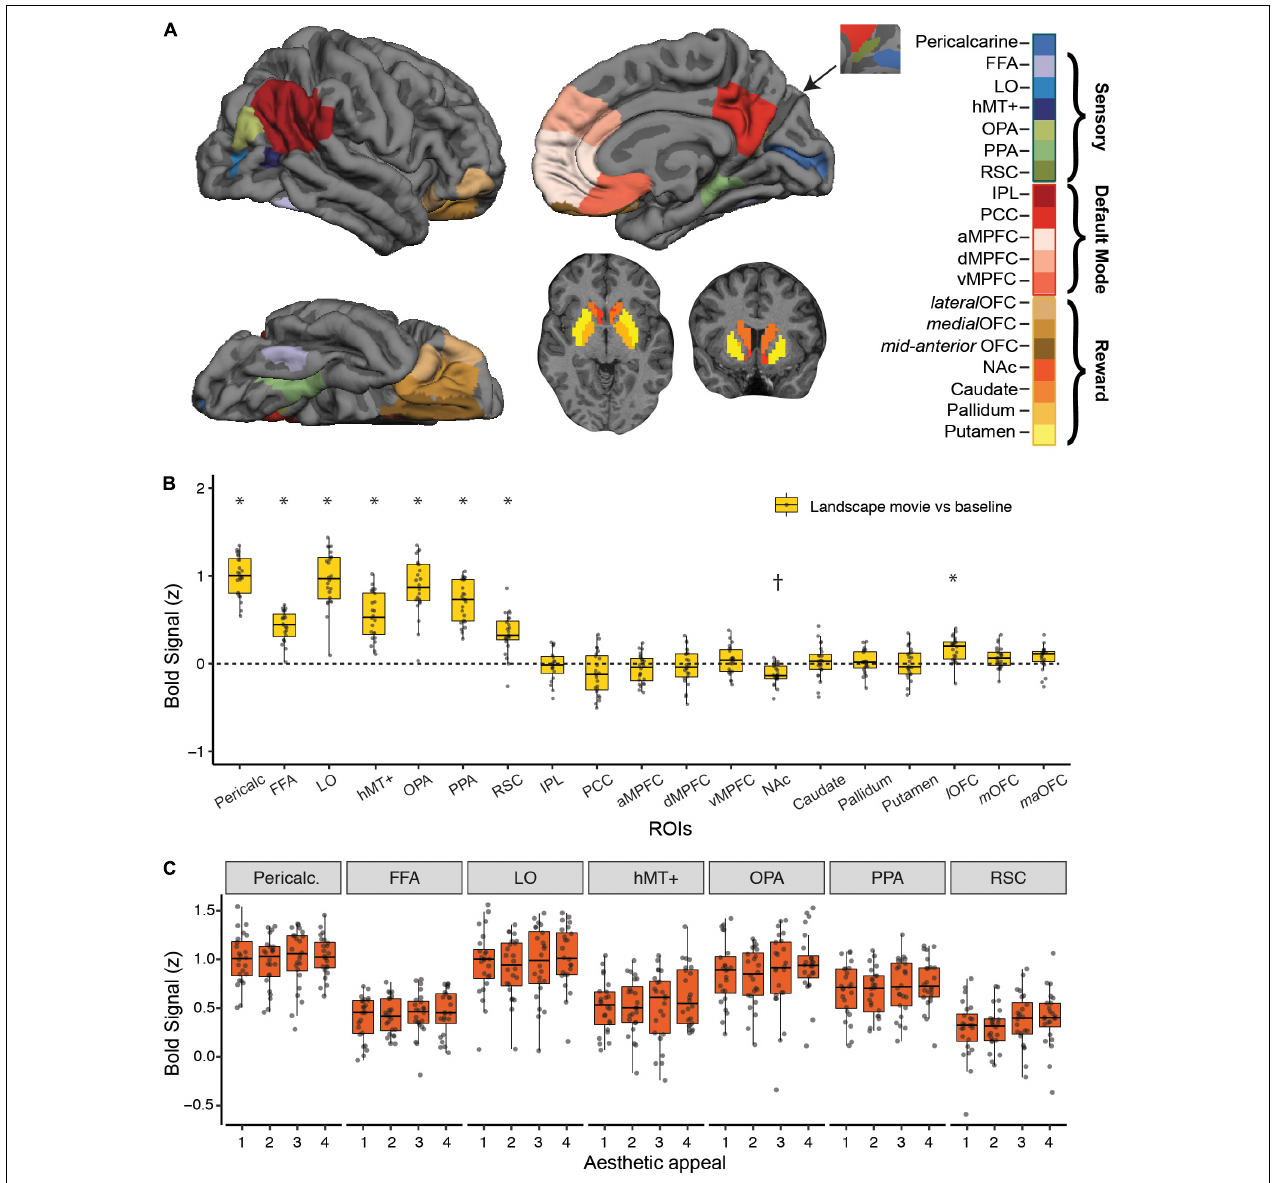
FIGURE 2 | Strength of BOLD activation vs. baseline and effect of aesthetic appeal in visual, default-mode and reward networks. (A) Nineteen a priori regions of interest (ROIs) from three networks were identified and mean signal from each ROI was extracted for each participant. (B) Activations in each ROI for viewing landscape movies (vs. baseline). All visual ROIs were strongly engaged by landscape movies, with pericalcarine, LO, and OPA showing the strongest activation. *Indicates greater and † indicates lesser activation compared to a resting baseline (C) Beta values from a univariate activation analysis in a priori visual ROIs did not reveal significant differences across 4 different levels of aesthetic appeal. In B , C , boxplots display the median (center line), the 25th and 75th percentiles (box edges) and extrema (whiskers). Filled circles represent scores for each participant and points outside the reach of the whiskers are individual outliers; N =